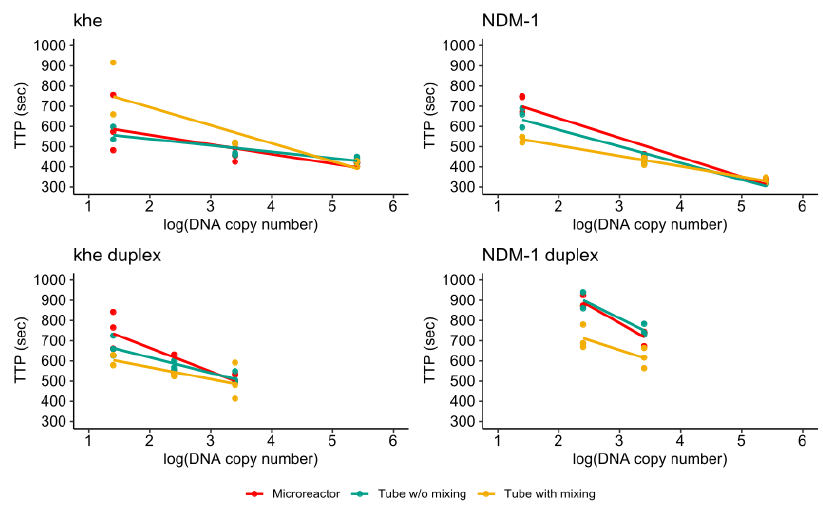
Figure 13. Comparison of TTP-values measured for single- and duplex assays targeting khe and bla NDM-1 .